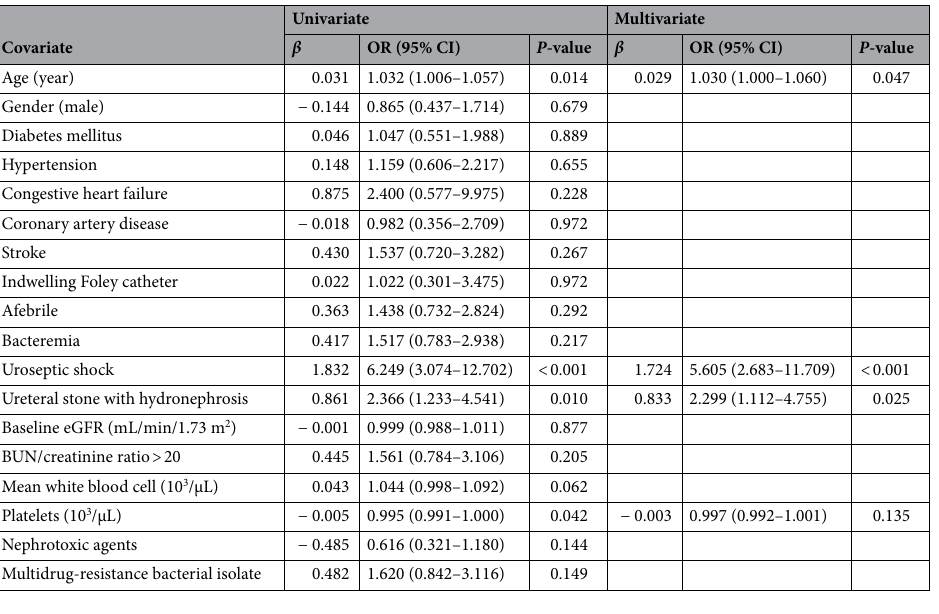
Table 3. Univariate and multivariate logistic regression analyses of factors related to acute kidney injury in hospitalized urinary tract infection patients with urolithiasis. Cox & Snell R 2 = 0.197, Nagelkerke R 2 = 0.278. eGFR estimated glomerular filtration rate, BUN blood urea